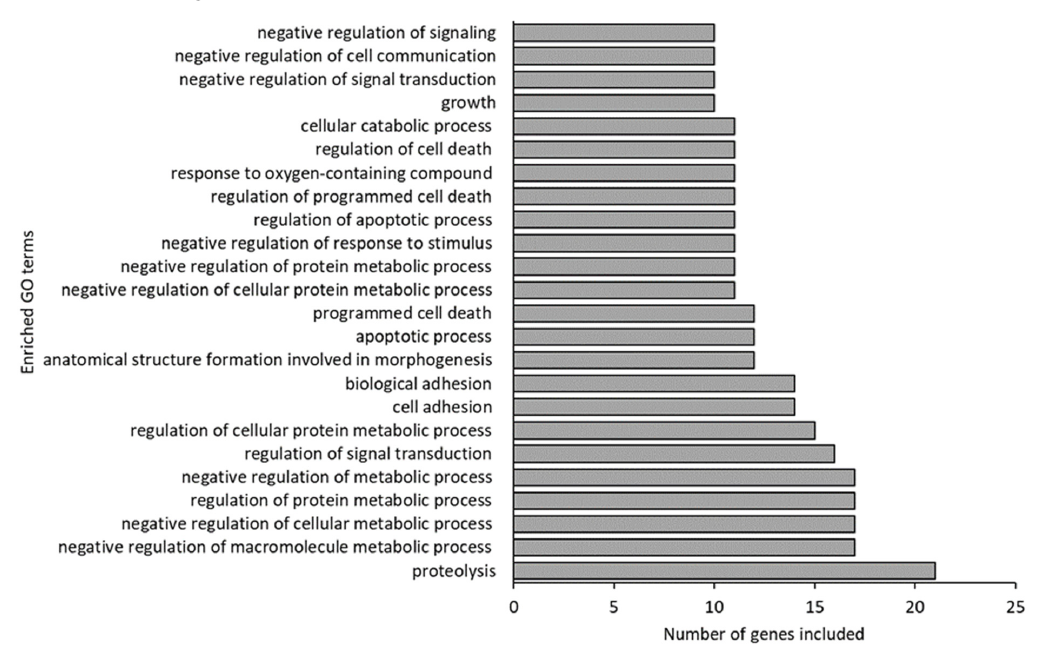
Figure 4. Significantly enriched Gene Ontology (GO) terms in conventional fish compared with germ-free fish.